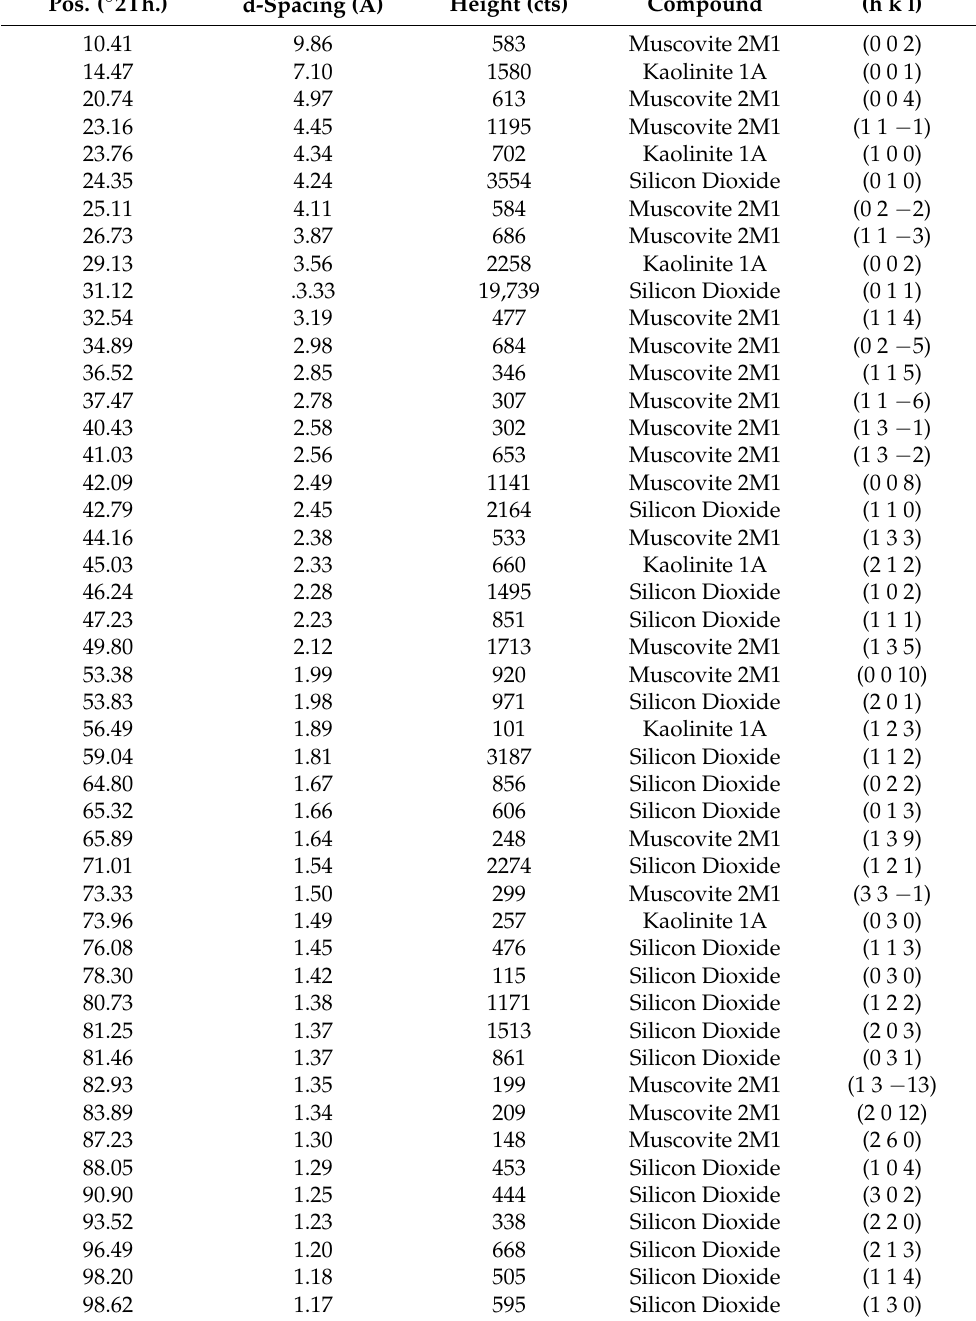
Table 1. Results of the claystone X-ray